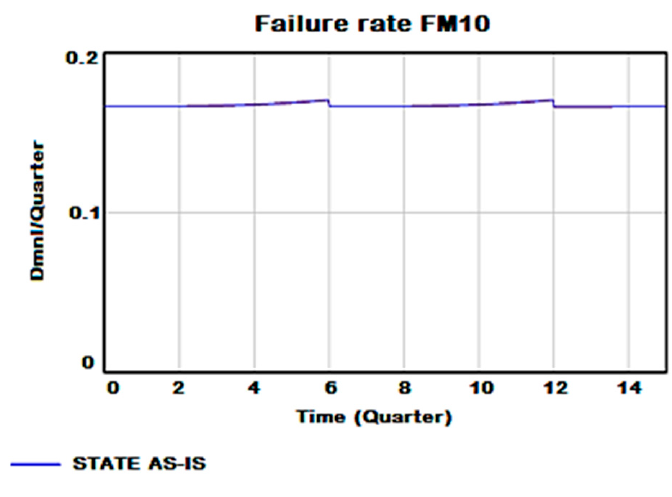
Figure 8. AS-IS FM10 Guide usury. For the failure modes FM19 (transfer chain breakage) (Figure 9) and FM1 (tunnel chain breakage) (Figure 10), on the other hand, cycle times have been set as 3 and 4 years, respectively, because the two chains are changed with such intervals as required by the preventive maintenance plan drawn up by the manufacturer.